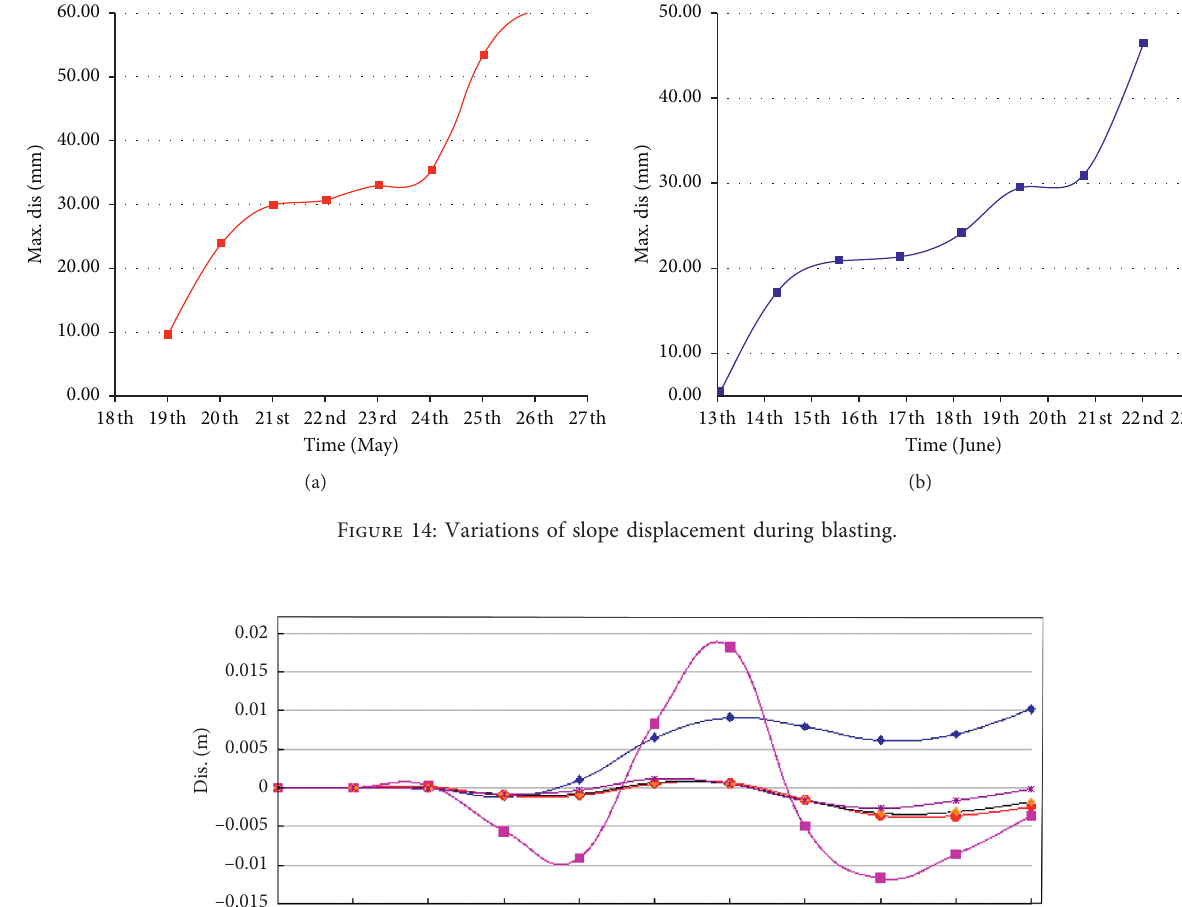
Figure 15: Displacement curves monitored at a certain point under blasting action.